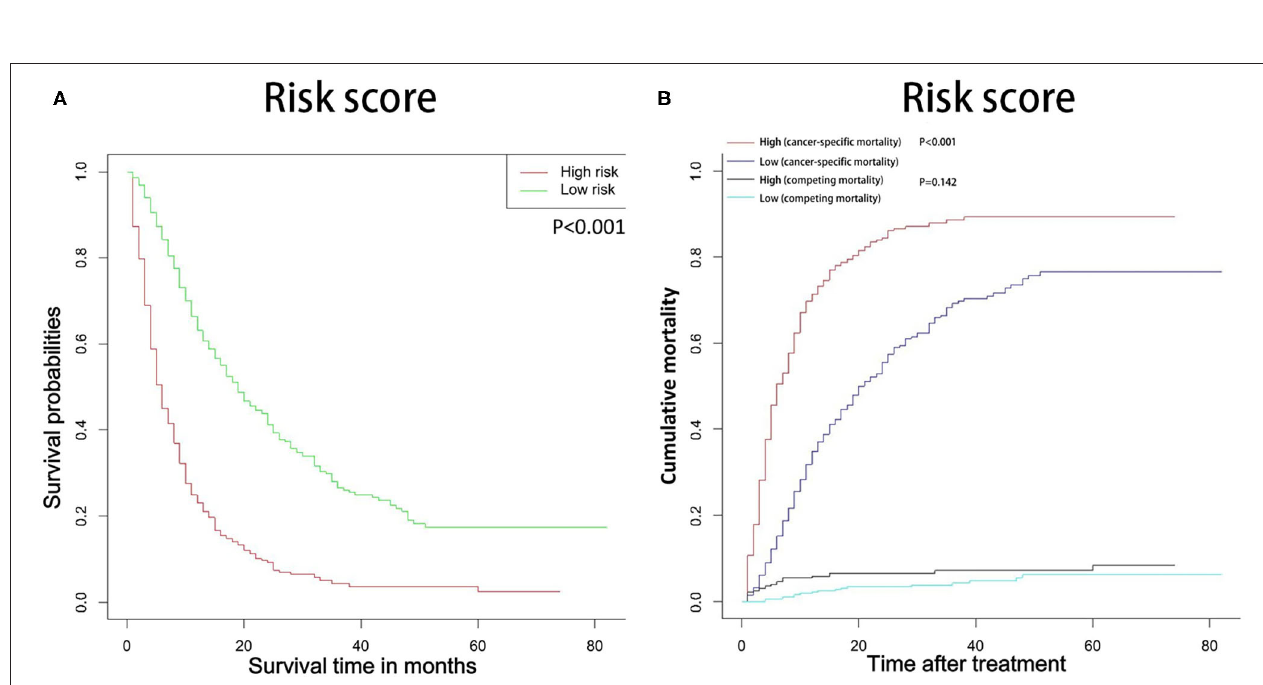
FIGURE 8 | OS (A) and CSS (B) stratified by the risk levels of the nomogram-predicted survival probabilities. OS, overall survival; CSS, cancer-specific survival.